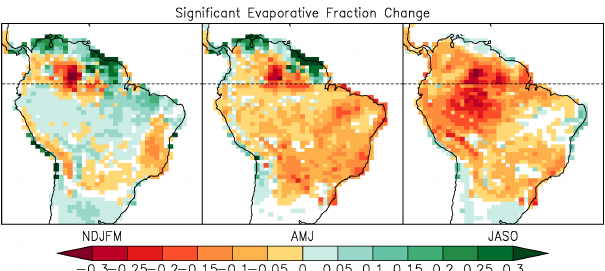
Figure 7. Changes to evaporative fraction in NDJFM, AMJ and JASO; shading indicates significance at the 95% confidence level.